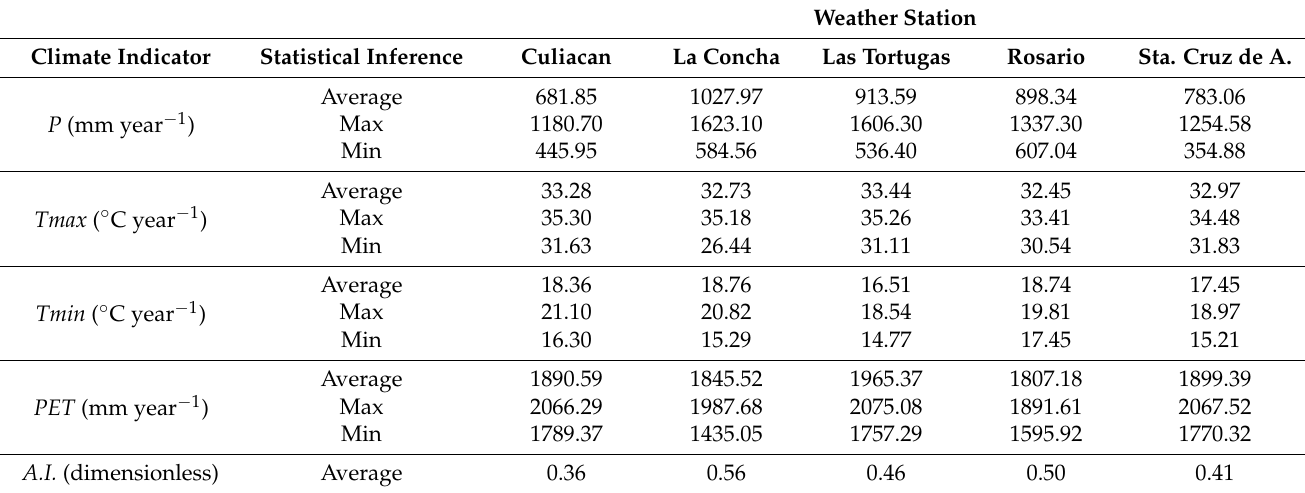
Table 2. Average, maximum and minimum values of P , Tmax , Tmin and PET , and average value of A.I